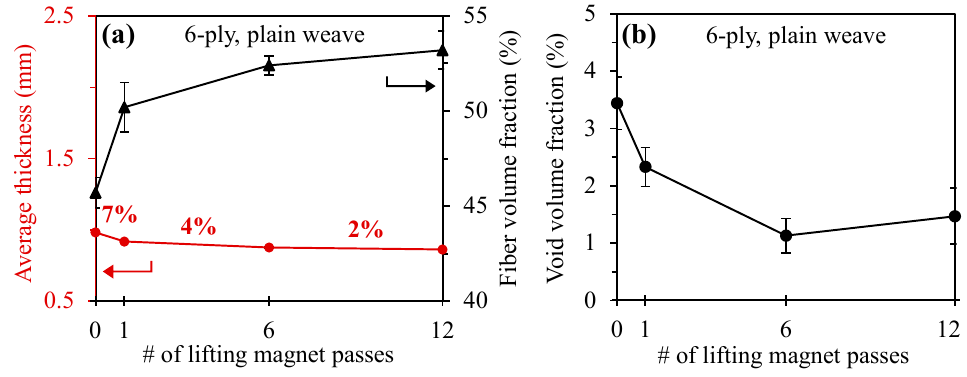
Figure 5. ( a ) Thickness, fiber volume fraction, and ( b ) void volume fraction of plain weave laminates fabricated with WLVB and increasing number of magnet passes (i.e., 0, 1, 6, and 12 passes). Note: Error bars show the 95% confidence interval ( n = 6 samples for fiber volume fraction and void volume fraction; n = 70 samples for laminate thickness). The percentages shown in ( a ) correspond to the percent thickness reduction between number of passes labeled in the figure.